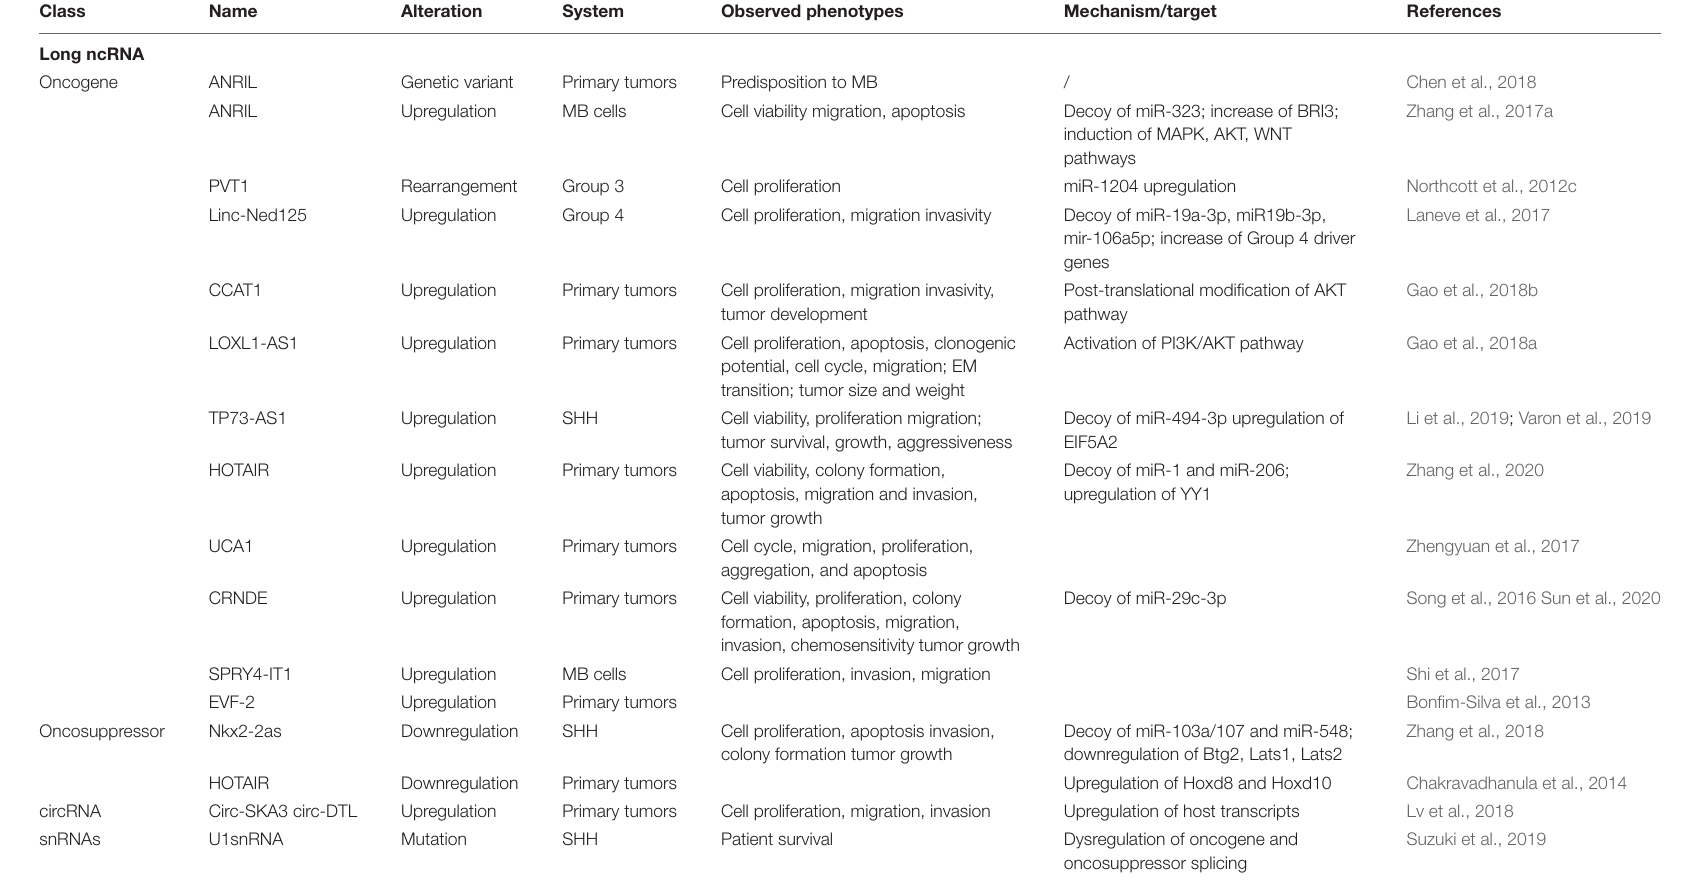
TABLE 1 | Summary of the features and function of lncRNAs, circRNAs, and snRNAs involved in MB.